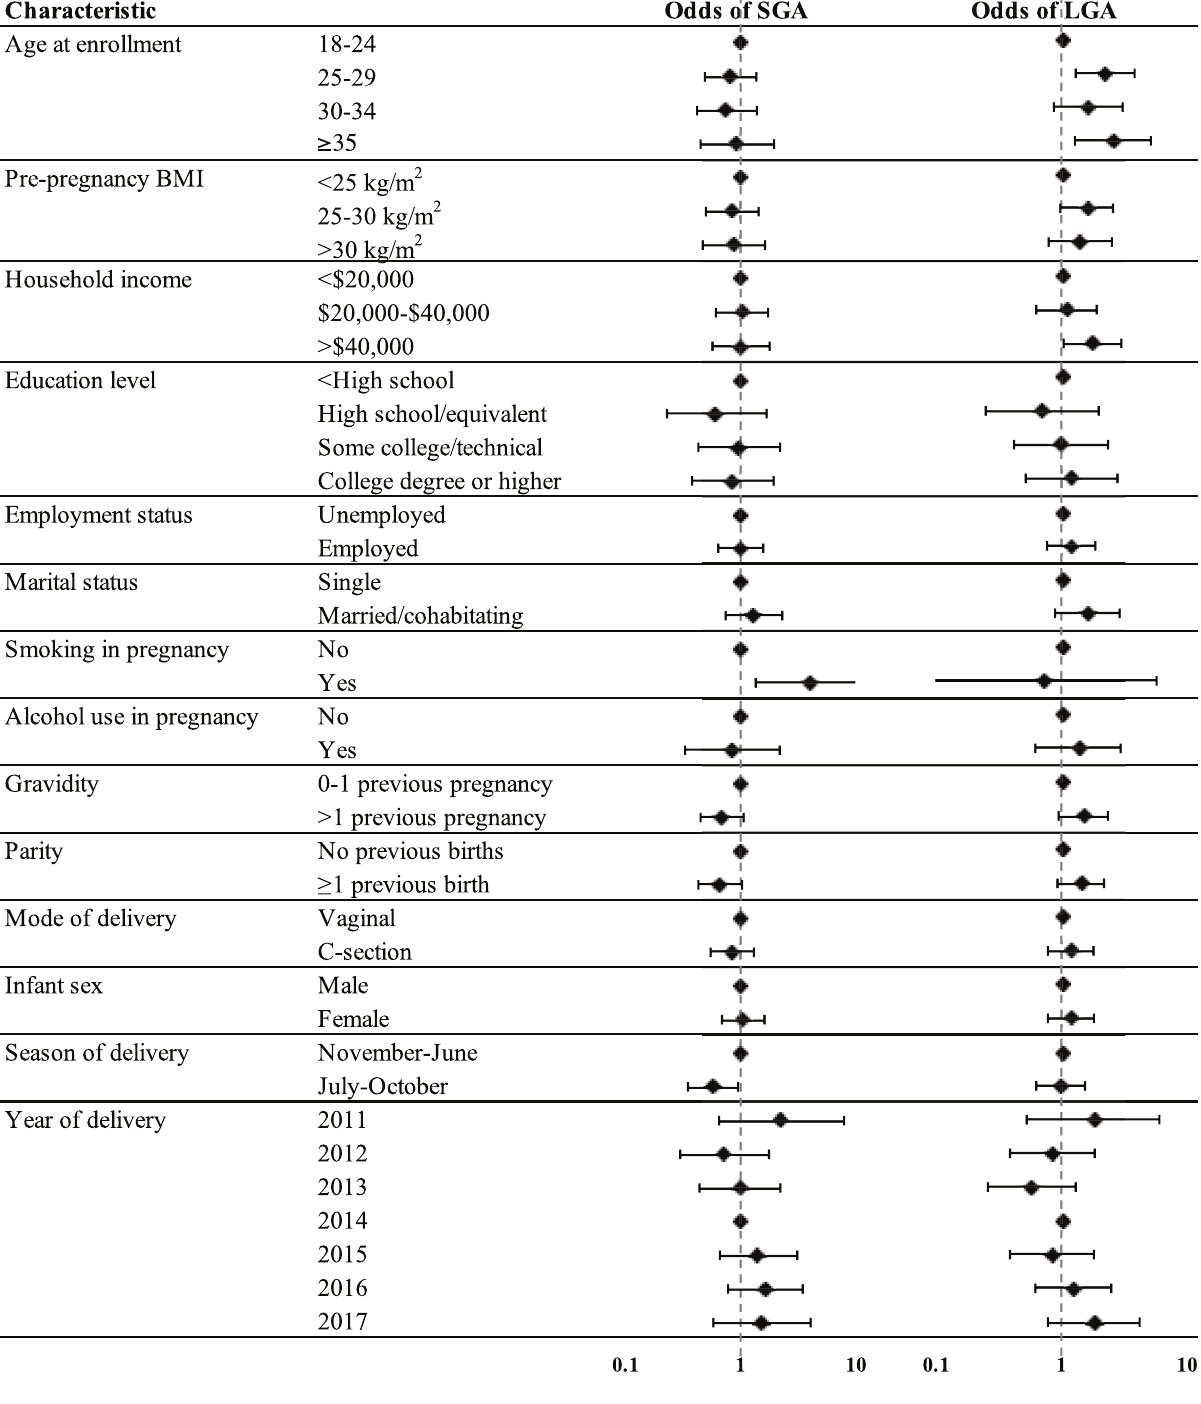
PLOS ONE | https://doi.org/10.1371/journal.pone.0217770 June 13,